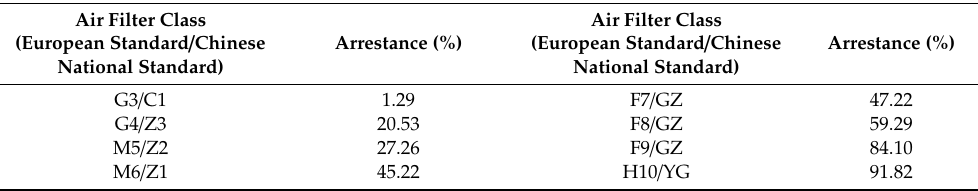
Table 6. PM2.5 arrestance of air filter